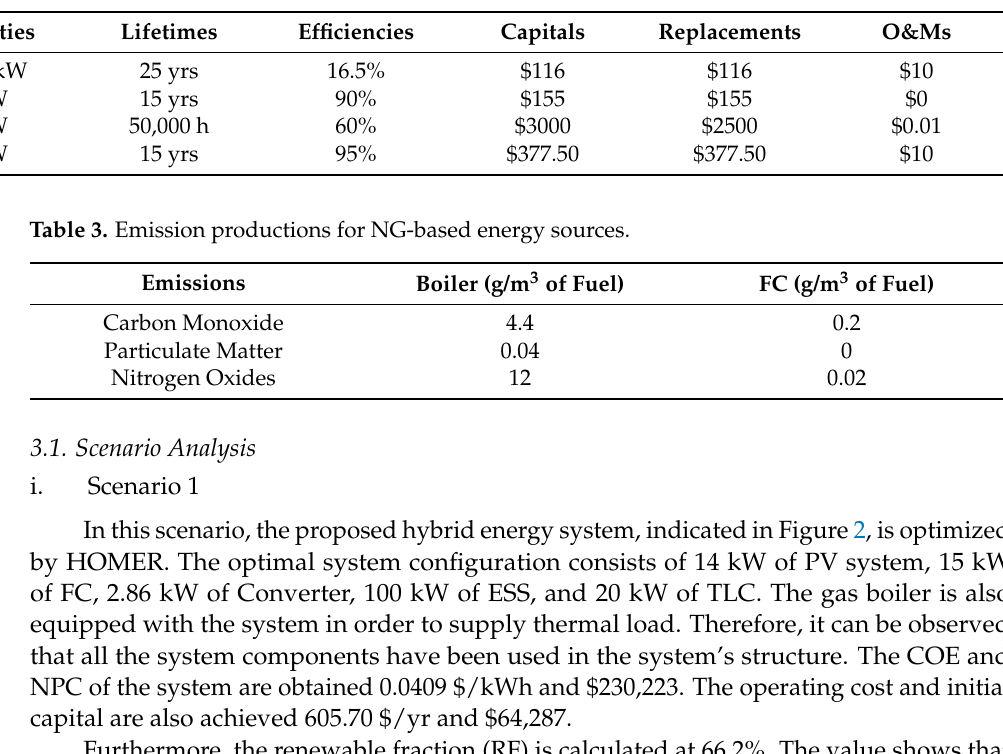
Table 2. Technical and economic characteristics of the system equipment.